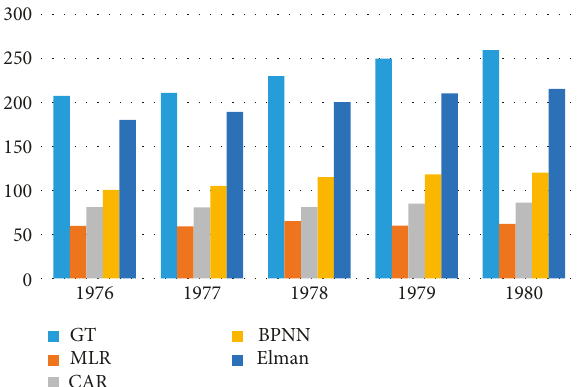
Figure 11: Forecast of agricultural output value